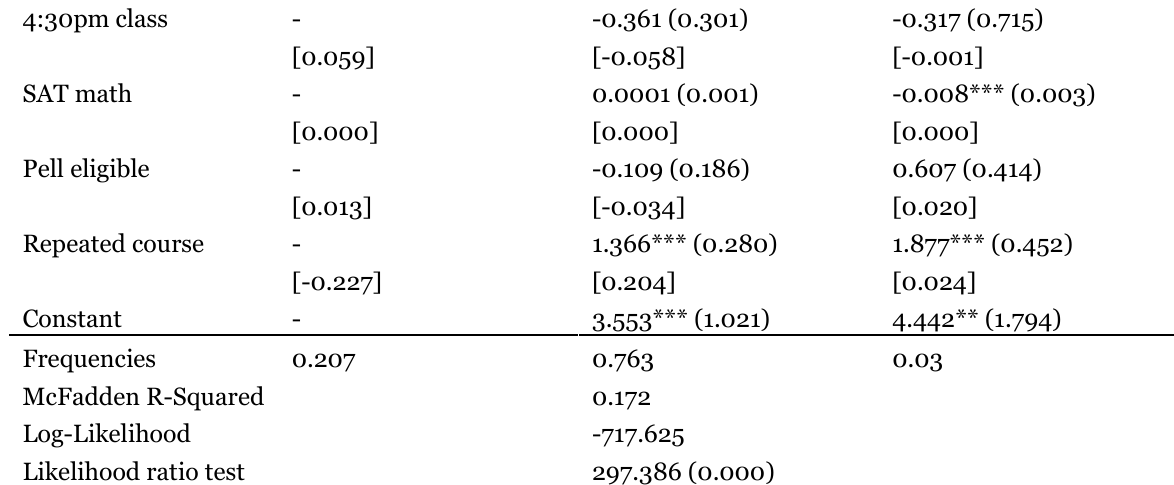
*Note. Table reports coefficient estimates with standard errors in parentheses. The numbers in square brackets are implied average marginal effects. Statistical significance at the 1, 5, and 10 percent level is denoted by ***, **, * respectively. Note that for identification, the coefficients in the negative category are constrained to